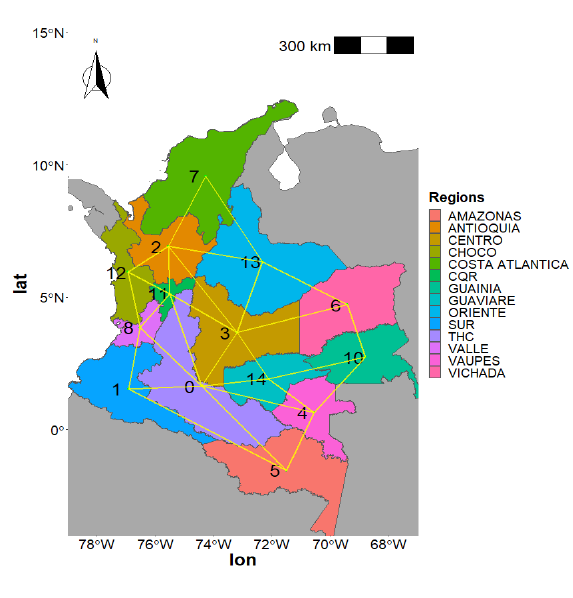
Figure 8. Map of the neighbourhood structure based on MRFs.